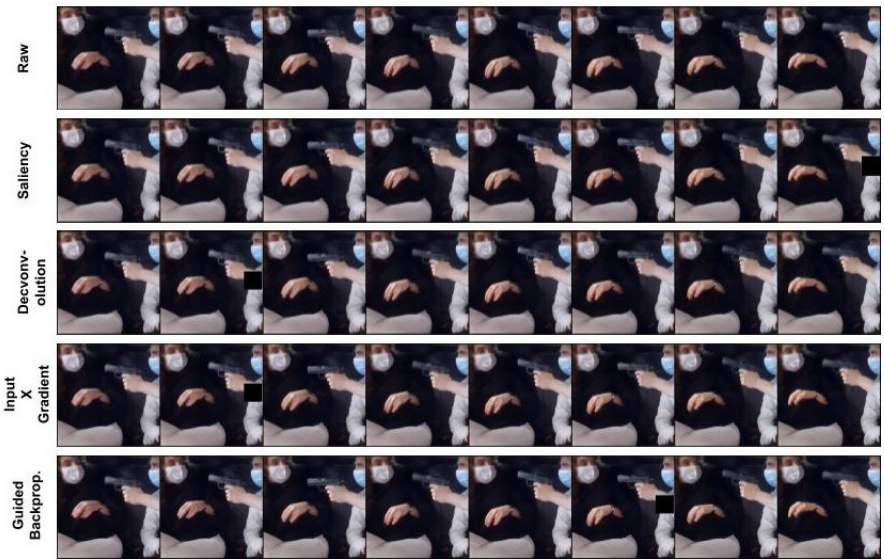
Figure 6. Spatial analysis. This example shows an example of the spatial analysis. Each row show the subregion occlude though each interpretability method